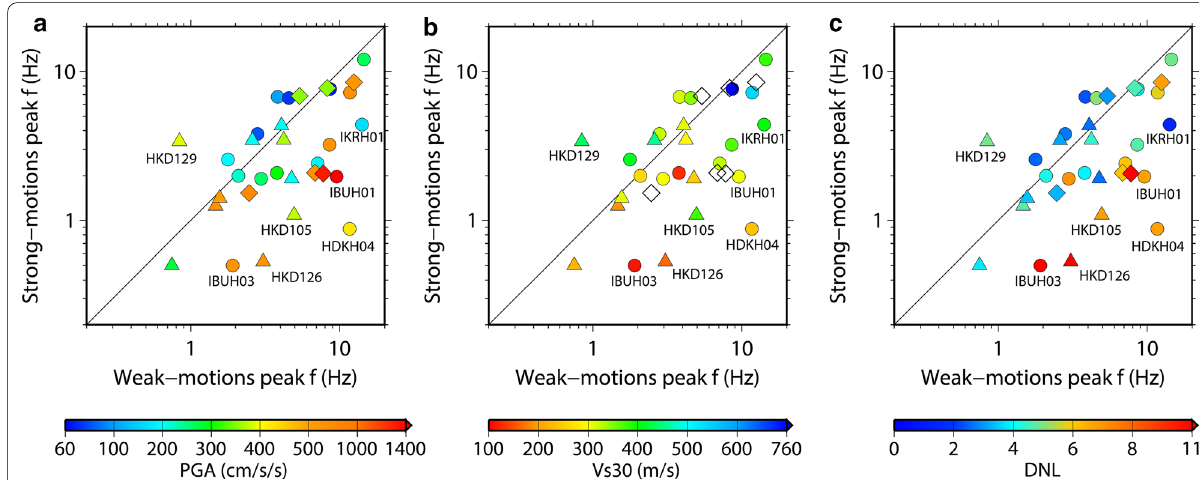
Fig. 15 Comparison of peak frequencies from strong-motions (mainshock) and weak-motions S-to-B spectral ratios for horizontal components at the KiK-net sites (circles) and H-to-V spectral ratios at the K-NET sites (triangles). The data points are color-coded by horizontal vector PGAs at the surface in a , Vs30 values in b , and DNL values based on the S-to-B spectral ratios in c , respectively. The sites where Vs30 values were not estimated are denoted by diamonds (see Table 3 for the Vs10 values at the sites). Some data points that might be of interest to readers are provided with their site codes near the data